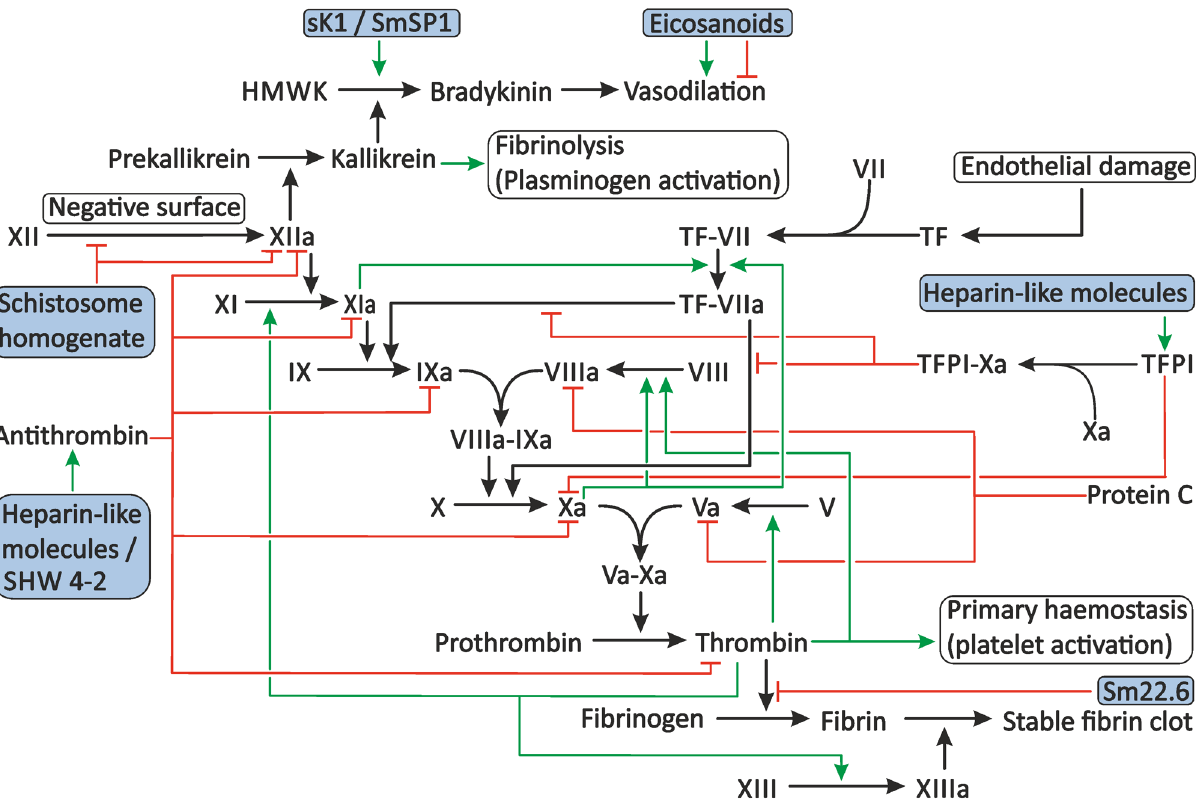
Figure 3. Proposed modulation of secondary haemostasis and vascular tone by schistosomes. Secondary haemostasis can be activated through two different pathways: either by the presence of TF or by contact of coagulation factors with collagen, pathogens, or other negatively charged surfaces. This triggers a cascade of cleavage reactions, ultimately leading to the cleavage of fibrinogen to fibrin and the formation of a stable fibrin clot. This process is regulated by antithrombin, TFPI, and protein C. Schistosomes potentially interfere with secondary haemostasis at several steps in the cascade. Schistosome whole worm homogenate blocks the conversion of XII to XIIa and inhibits the actions of XIIa. The proteolytic activity of thrombin is inhibited by the schistosome antigen Sm22.6. Furthermore, schistosome heparin-like glycosaminoglycans may enhance the activity of antithrombin and, possibly, TFPI, and the schistosome serpin SHW 4-2 might mimic human antithrombin. The vascular tone can be influenced by schistosomes through the production of both vasodilating and vasoconstricting eicosanoids and the presence of sK1 and SmSP1 that could potentially convert HMWK into the vasodilator bradykinin. The green arrows indicate stimulation. Inhibition is indicated by the red lines. The shaded boxes indicate schistosome proteins. Abbreviations: activated coagulation factor XII (XIIa), coagulation factor XII (XII), High-molecular-weight kininogen (HMWK), tissue factor (TF), tissue factor pathway inhibitor (TFPI).